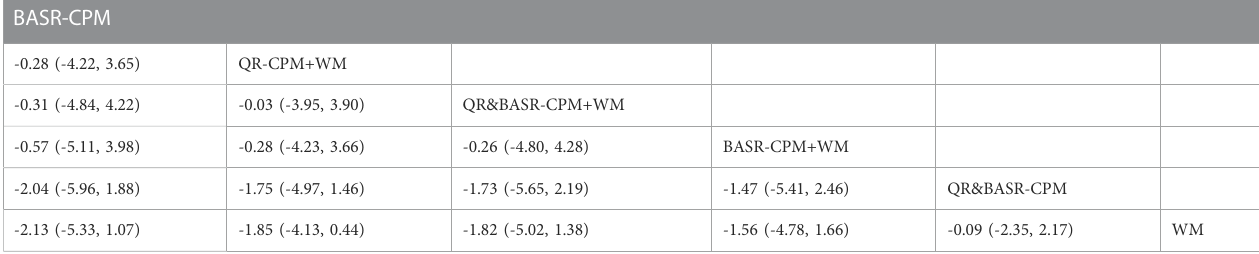
TABLE 10 Results of network meta-analysis for NT-proBNP.